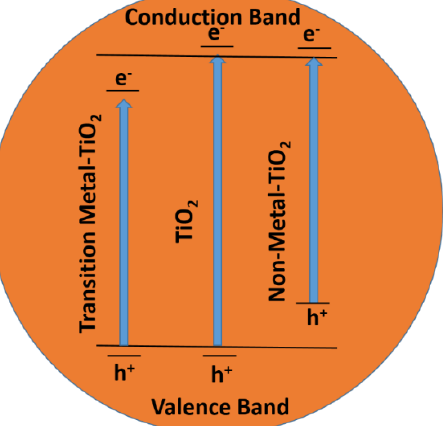
Figure 10. The energies of the valence band levels and conduction band level energies of transition- metal-doped TiO 2 , pure TiO 2 , and non-metal-doped TiO 2